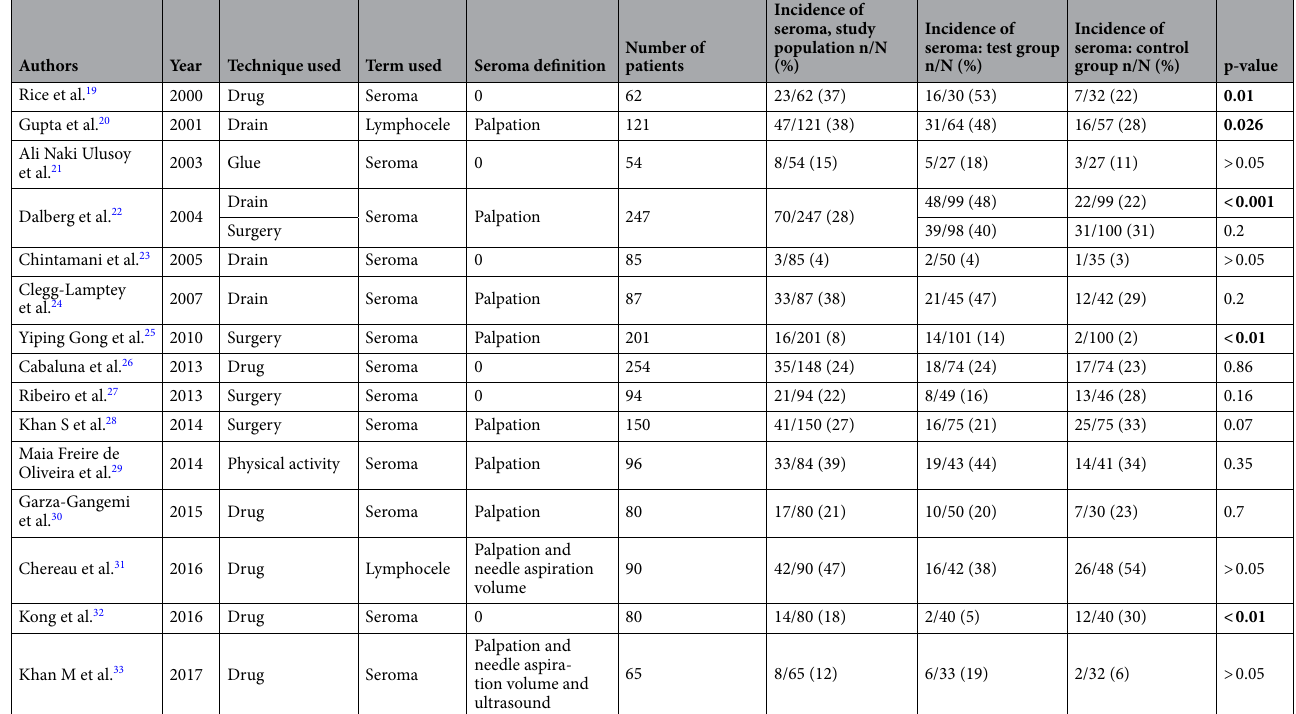
Table 1. Characteristics of included stories. Significant values are in bold.